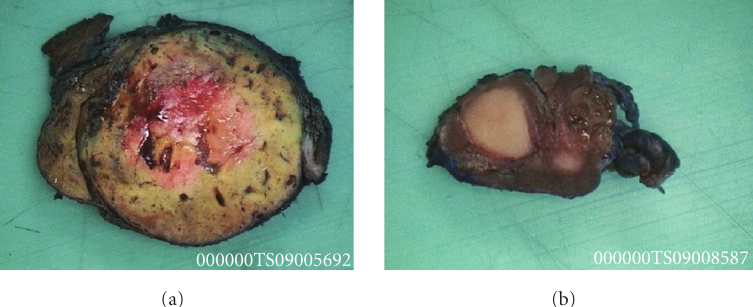
Figure 3: Macroscopic specimens showing metastatic RCC within the submandibular (a) and thyroid (b) glands. Solid metastatic tumours can be seen to be surrounded by normal glandular tissue in both cases without any extraglandular